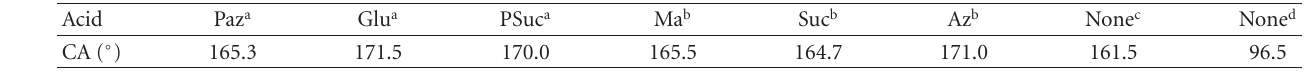
Table 4: Contact angles (CAs) on the surface coated with the nanospheres.